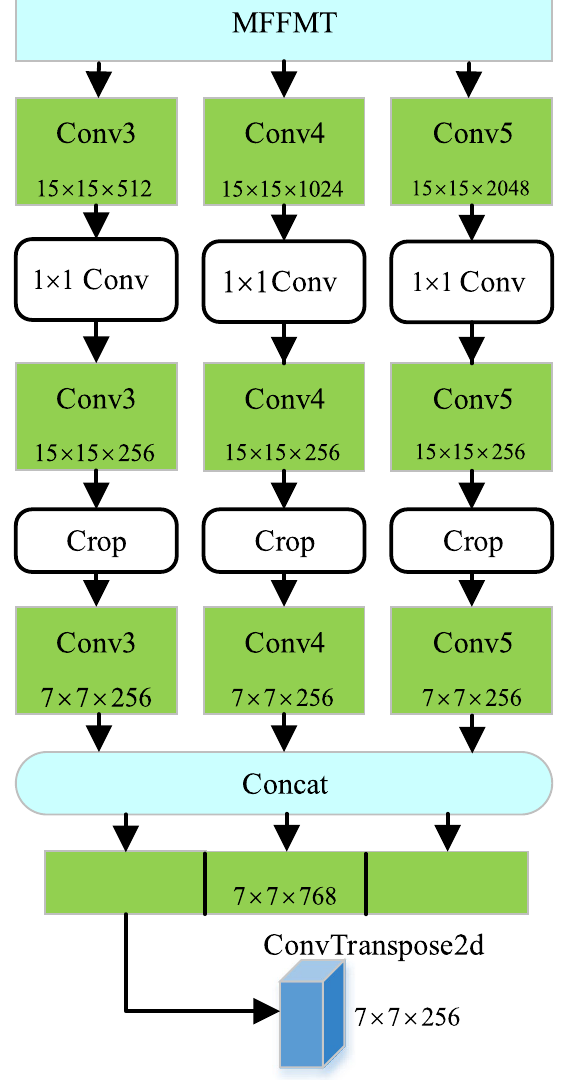
Fig. 2 Feature extraction of MFFMT module